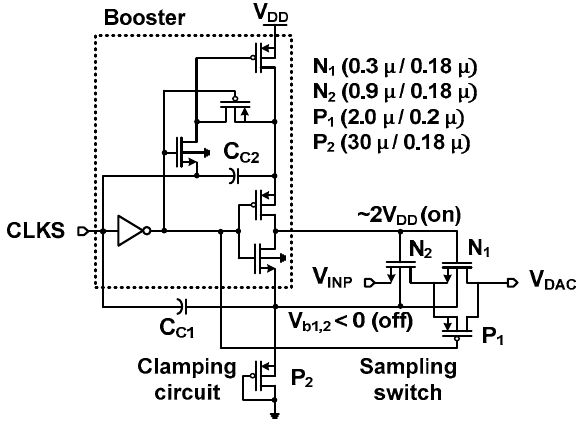
Figure 17. Schematic of the proposed bootstrap sampling switch.